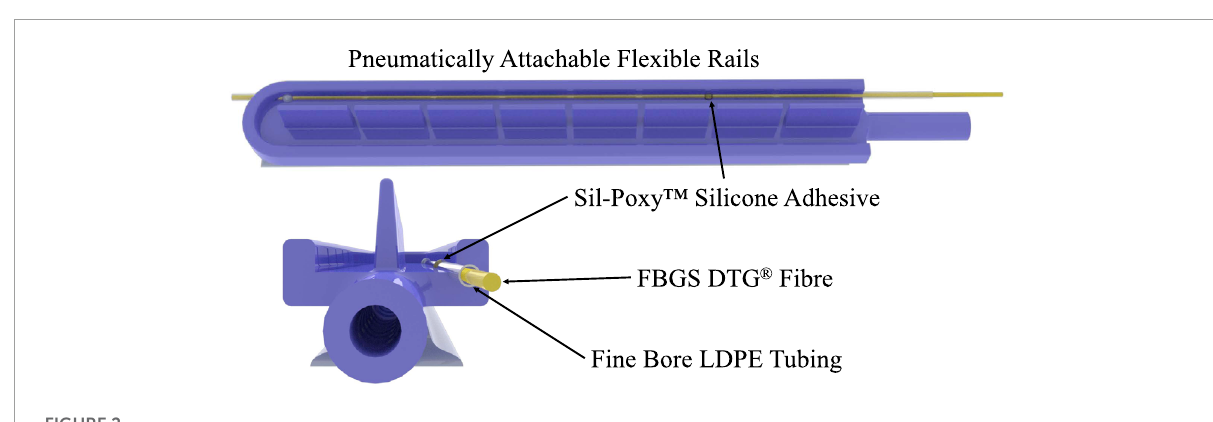
FIGURE 2 PAF rail with integrated Fine Bore LDPE tubing to house the FBGS DTG